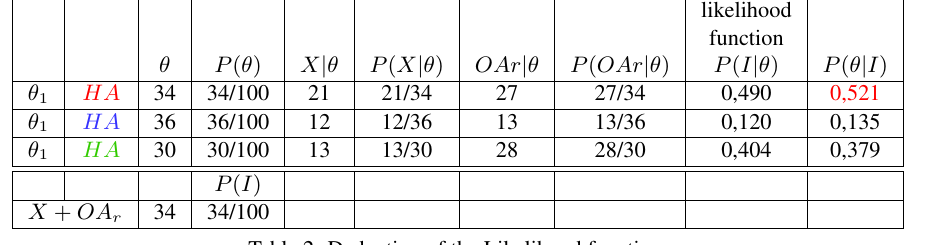
Table 2: Deduction of the Likelihood